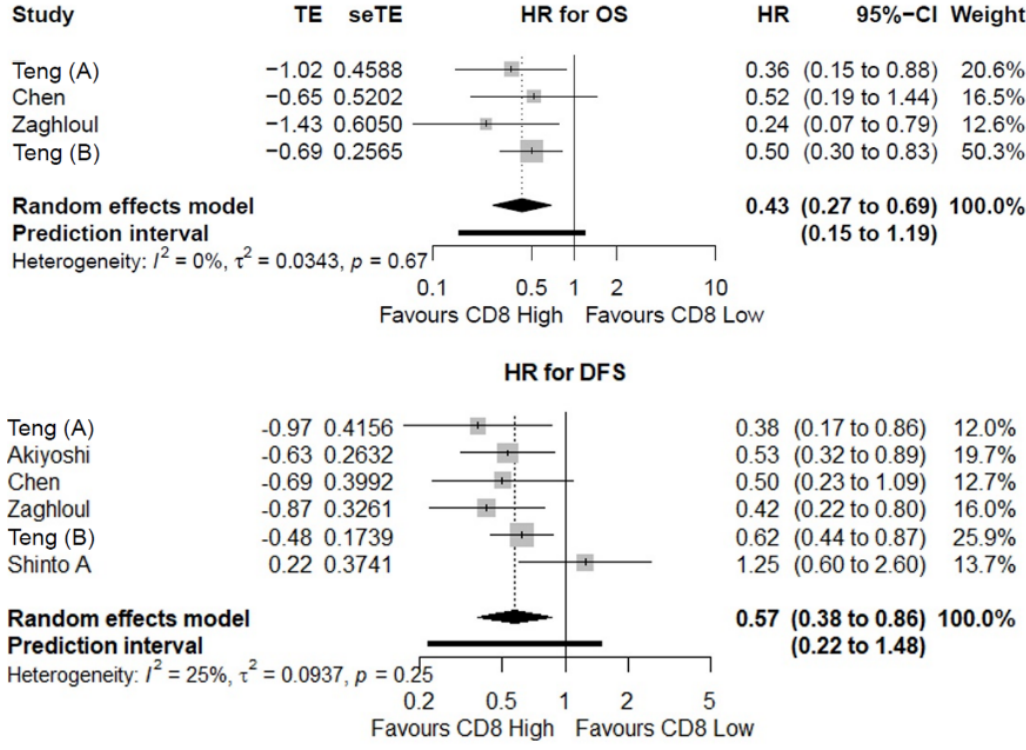
Figure 4. The prognostic value of CD8 + TILs. Meta-analyses of time-to-event data indicated a favorable overall survival (OS) and disease-free survival (DFS) for patients with high pretherapeutic CD8 + TILs density. HR: Hazard Ratio.